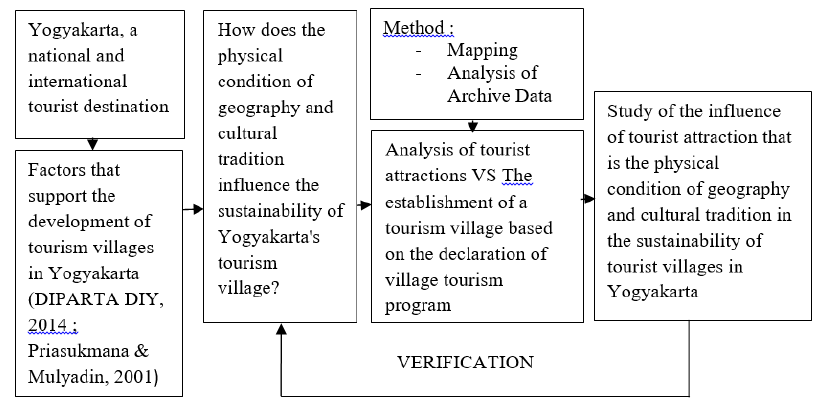
Figure 1. Research Schematic (author,